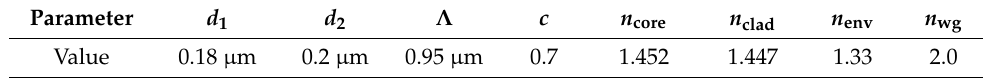
Table 1. Sensor’s design parameters used for the simulations.